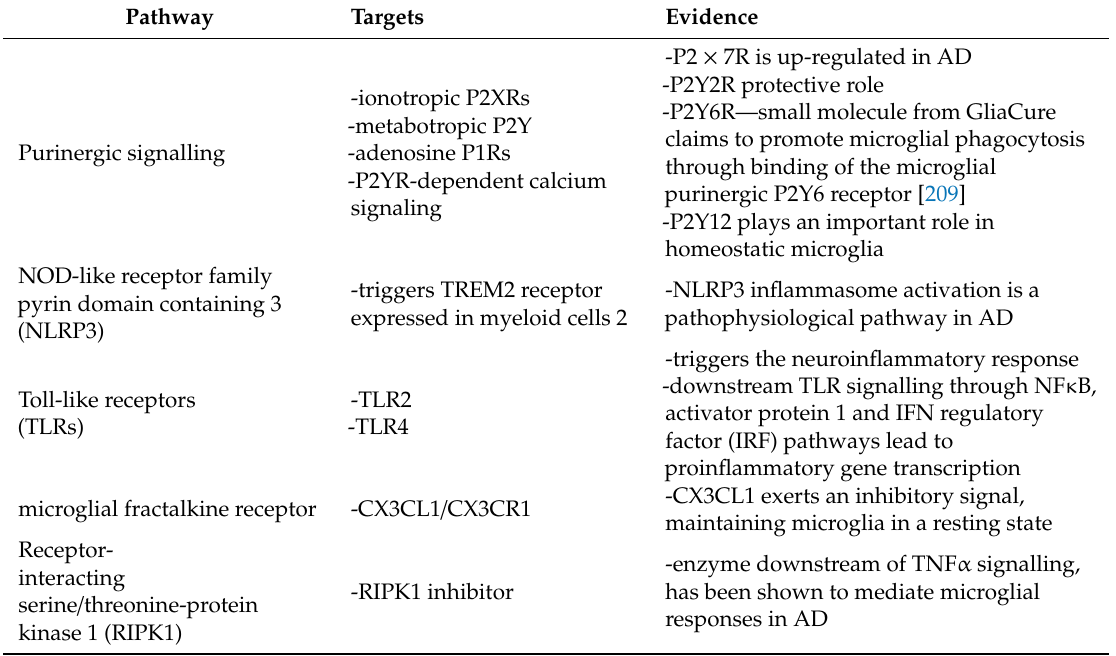
Table 3. Emerging microglial targets in AD based on